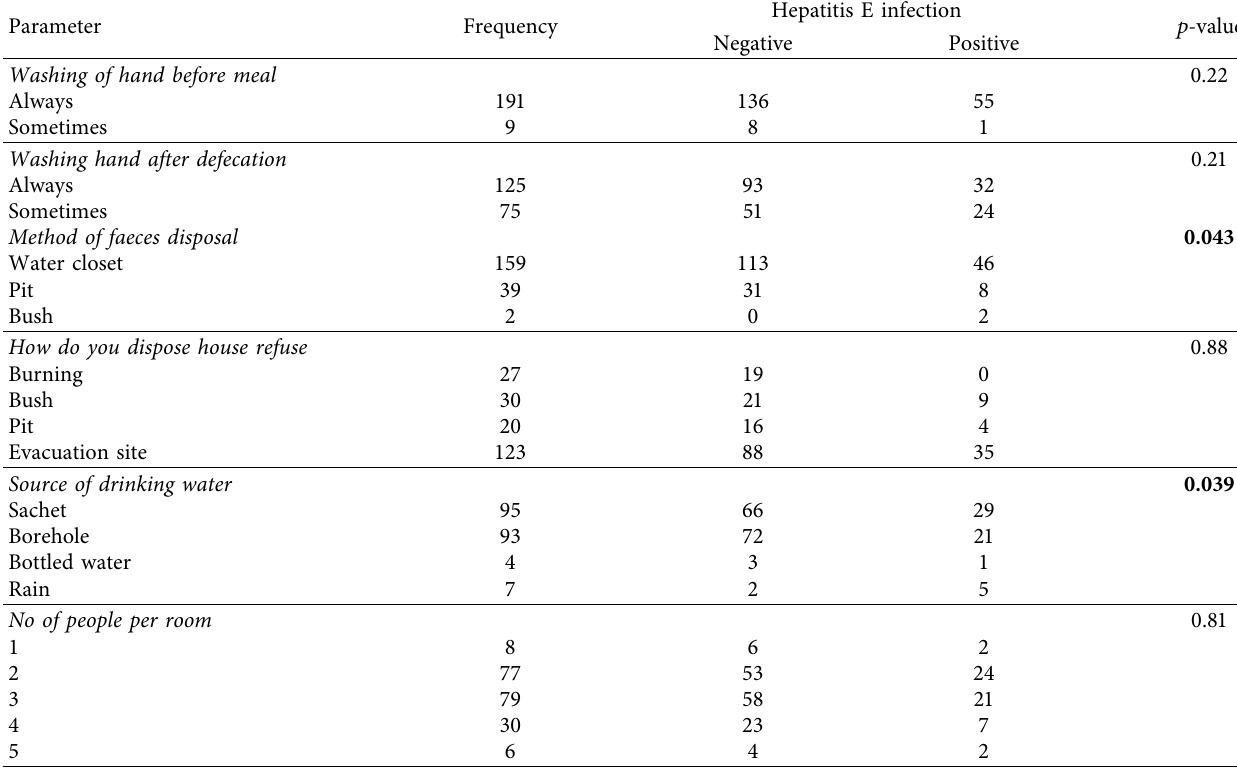
Table 2: Risk factors and hepatitis E infection among the